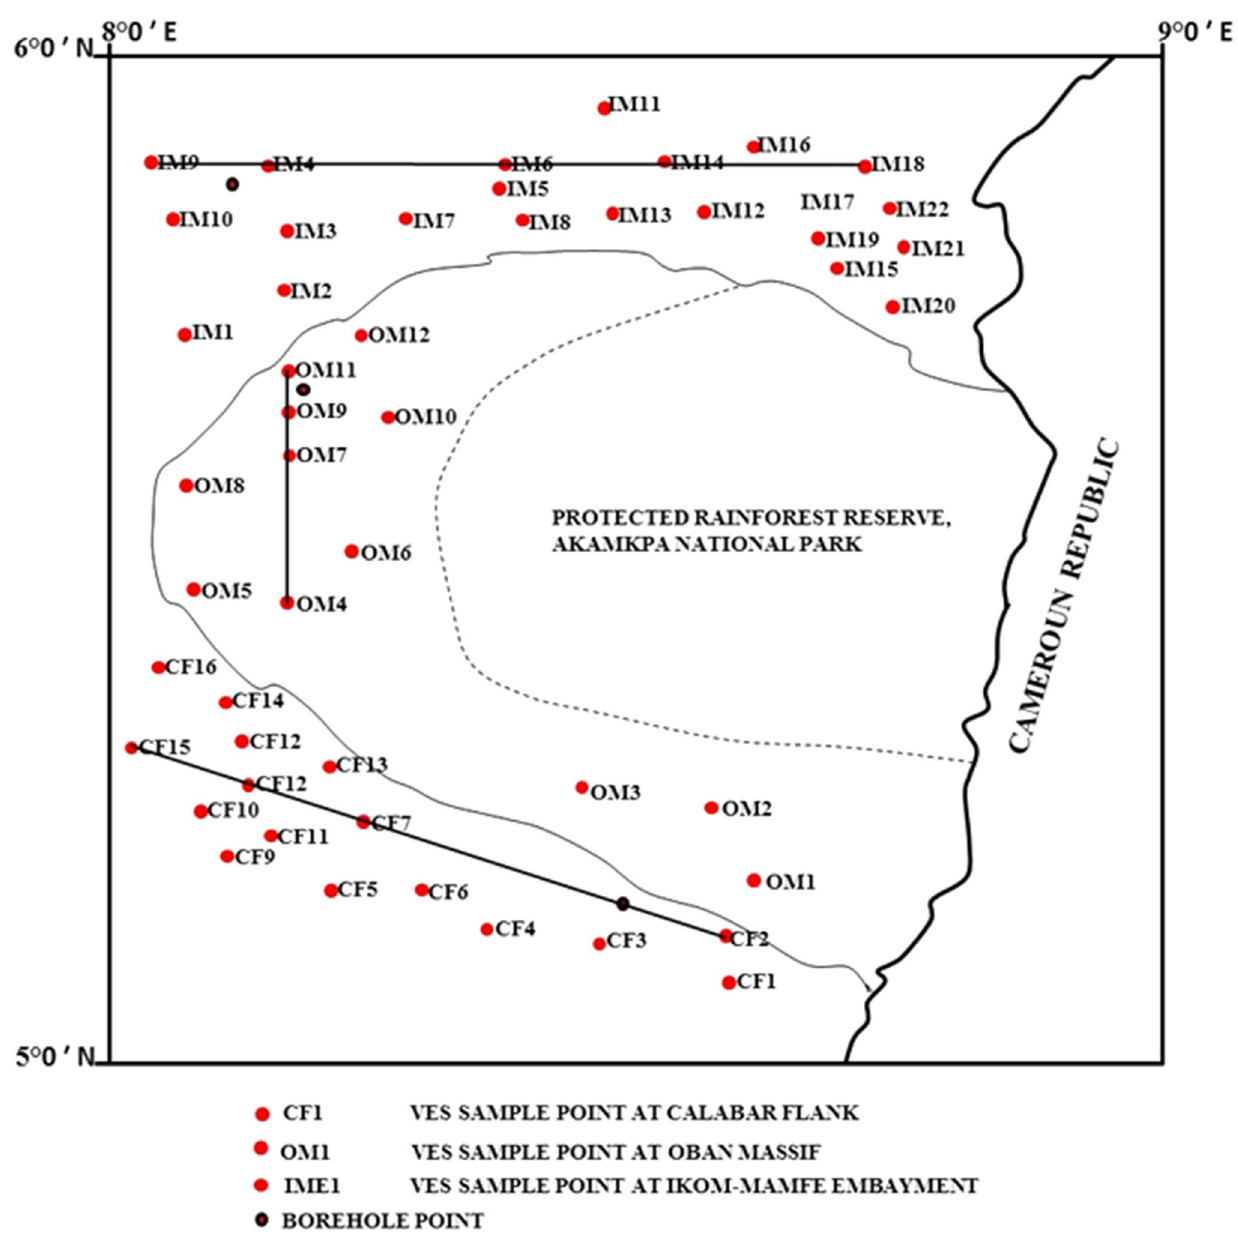
Fig. 2 Map of the study area including VES